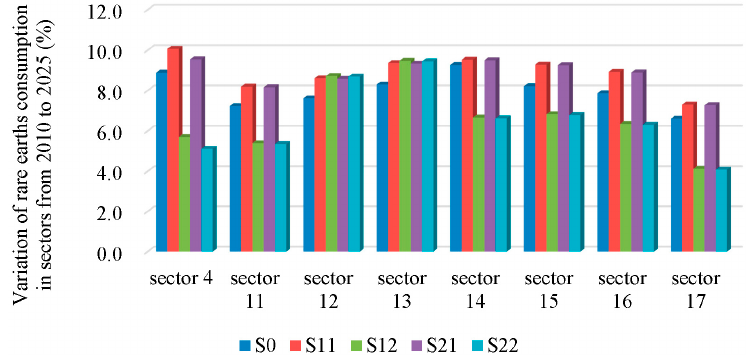
Figure 3. Rare earths consumption variation in relevant sectors from 2010 to 2025 (%).